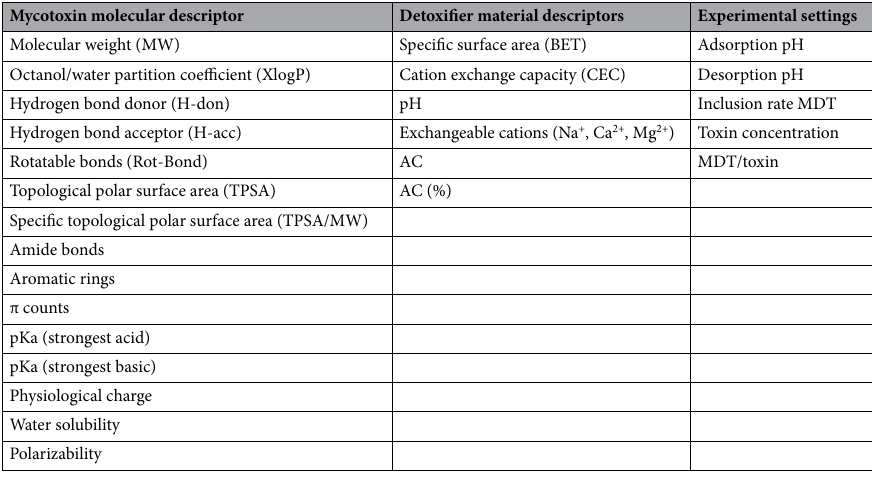
Table 2. Input vector